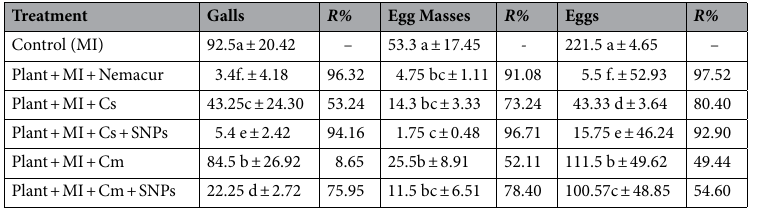
Table 2. The effect of Colpomenia sinuosa (Cs), Corallina mediterranea (Cm) extracts, synthesized silver nanoparticles and Nemacur 400 EC on the numbers of nematode galls (G), egg masses (EM) and eggs/ egg mass (Eggs) and Reduction % (R) in tomato crop infected with M. incognita (MI) after 60 days in a pot experiment Second item. * Data are means of 10 replicates. Values followed by the same letter(s) are not significantly different at p ≤ 0.05.